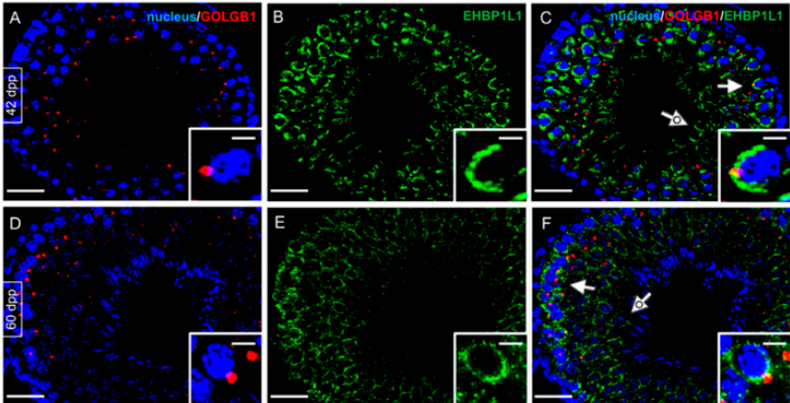
3.5. EHBP1L1 Analysis in Isolated Germ Cells and in Rat and Human SPZ Figure 8. Co-localization of EHBP1L1 and GOLGB1 at 42 and 60 dpp. ( A , D ) DAPI-fluorescent nuclear staining (blue) and GOLGB1 staining (red). ( B , E ) EHBP1L1 fluorescence (green). ( C , F ) Merged fluorescent channels (blue/red/green). ( A – C ) 42 dpp testis; ( D – F ) 60 dpp. GOLGB1 staining, initially